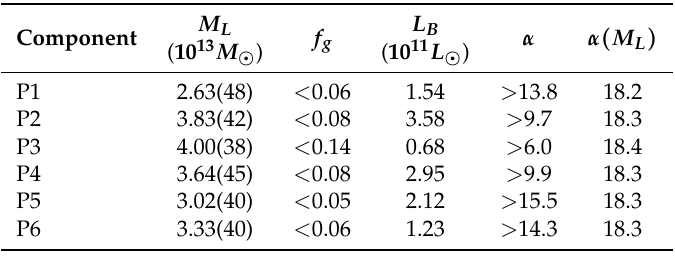
Figure 2. The Abell 520 cluster with distribution of galaxies, gas and contours from weak lensing [3]. Table 3. Lensing mass, gas fraction, stellar luminosity and the MOG α parameter (estimated assuming a stellar mass-to-light ratio of 1) and the same parameter computed from M L for components of Abell 520 [3]. Note that P3 corresponds to the “dark